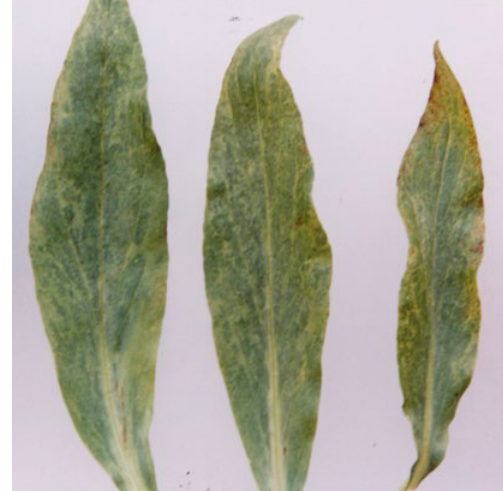
Figure 1. Vein clearing and mosaic on the leaves of Cen- tranthus ruber naturally infected with Cucumber mosaic virus (CMV).